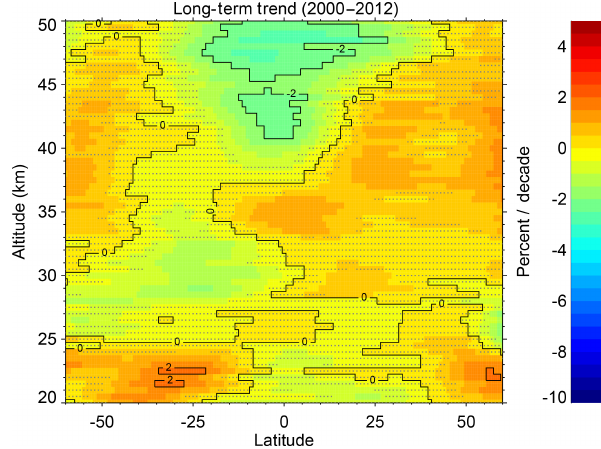
Figure 13. The result of the independent drift term used in the re- gression showing the relative drift from the SAGE II data for each of the other instruments. Derived drifts of ∼ 2–3%decade − 1 through most of the stratosphere for HALOE agree well with earlier studies but the lack of orthogonality between trend and drift terms during the overlap between the ACE-FTS and SAGE II missions causes anomalous results.